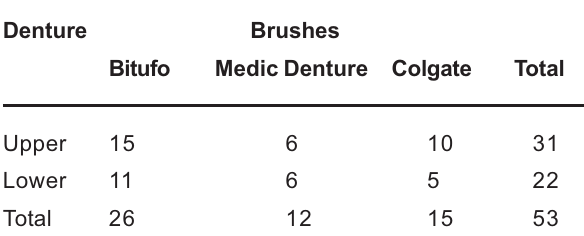
TABLE 4- Frequency of all kinds of